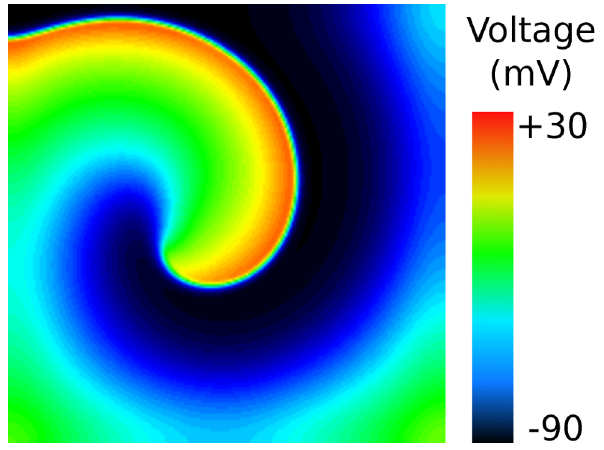
Figure 3. Cardiac electrophysiology: a re-entrant spiral wave. This figure displays the membrane voltage in a 2-D 3cm | 3cm monodomain simulation using the Luo-Rudy 1991 action-potential model [50] with the modifications and protocol suggested in [49]. See also Video S3.